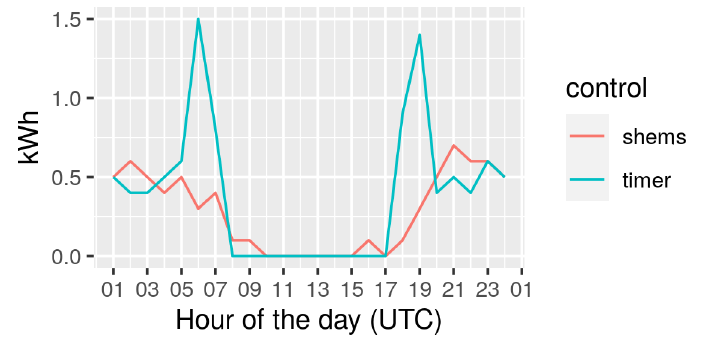
Figure 21. Grid energy import